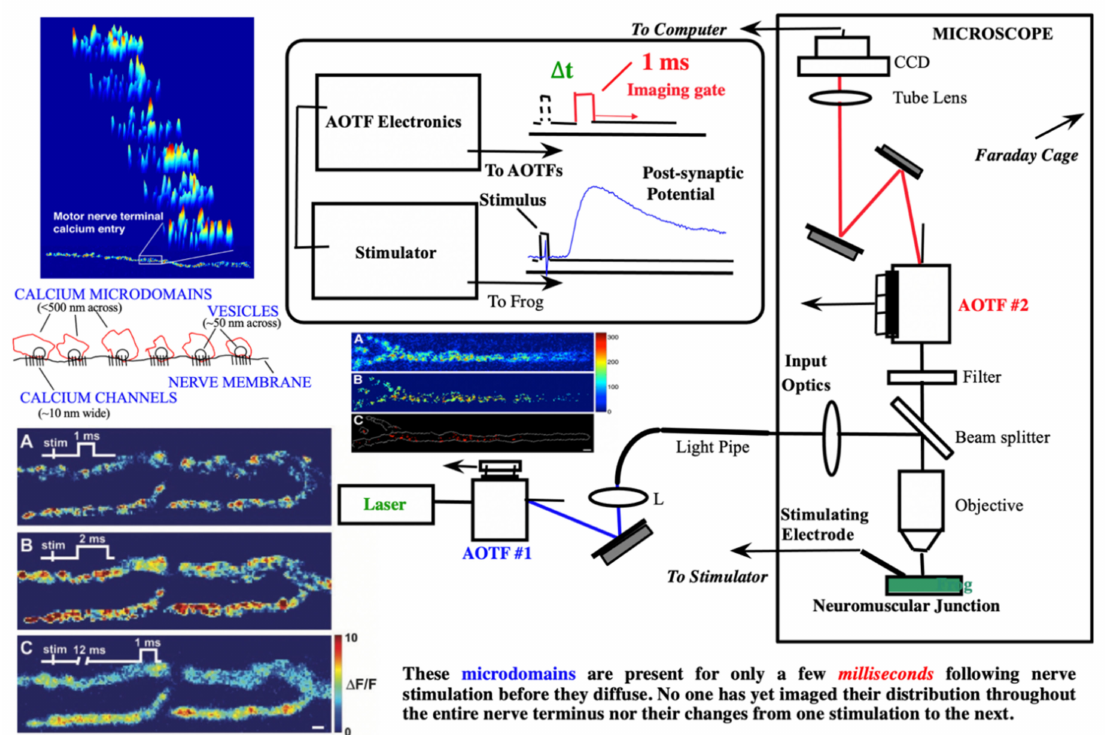
Figure 19. Calcium microdomain dynamics ( left ) imaged with a custom AOTF microscope ( right ) [150]. Left (bottom): The observed spatial profile of Ca 2+ -influx is dependent on the timing of the laser illumination window. ( A ). Representative difference image of Ca 2+ -entry with an illumination window of 1msec duration beginning 1.5 ms after nerve trunk stimulation. ( B ). Representative difference image of Ca 2+ -entry with an illumination window of 2 msec duration beginning 1.5 msec after nerve stimulation. The Ca 2+ -entry signal is more intense (resulting from a doubling in the dye illumination time) but also more diffusely distributed throughout the nerve terminal. ( C ). Representative raw difference image of Ca 2+ -entry with an illumination window of 1 msec duration beginning 12 msec after nerve stimulation. The Ca 2+ -entry signal is slightly reduced in magnitude as compared with A and much more diffusely distributed. The timing of the illumination window is shown schematically in each image. The pseudocolor scale bar is the same for all panels and is expressed as ∆ F/F(%). Scale bar, 2 µ m. Left (top): Upon each consecutive stimulation (diagonally), different domains are